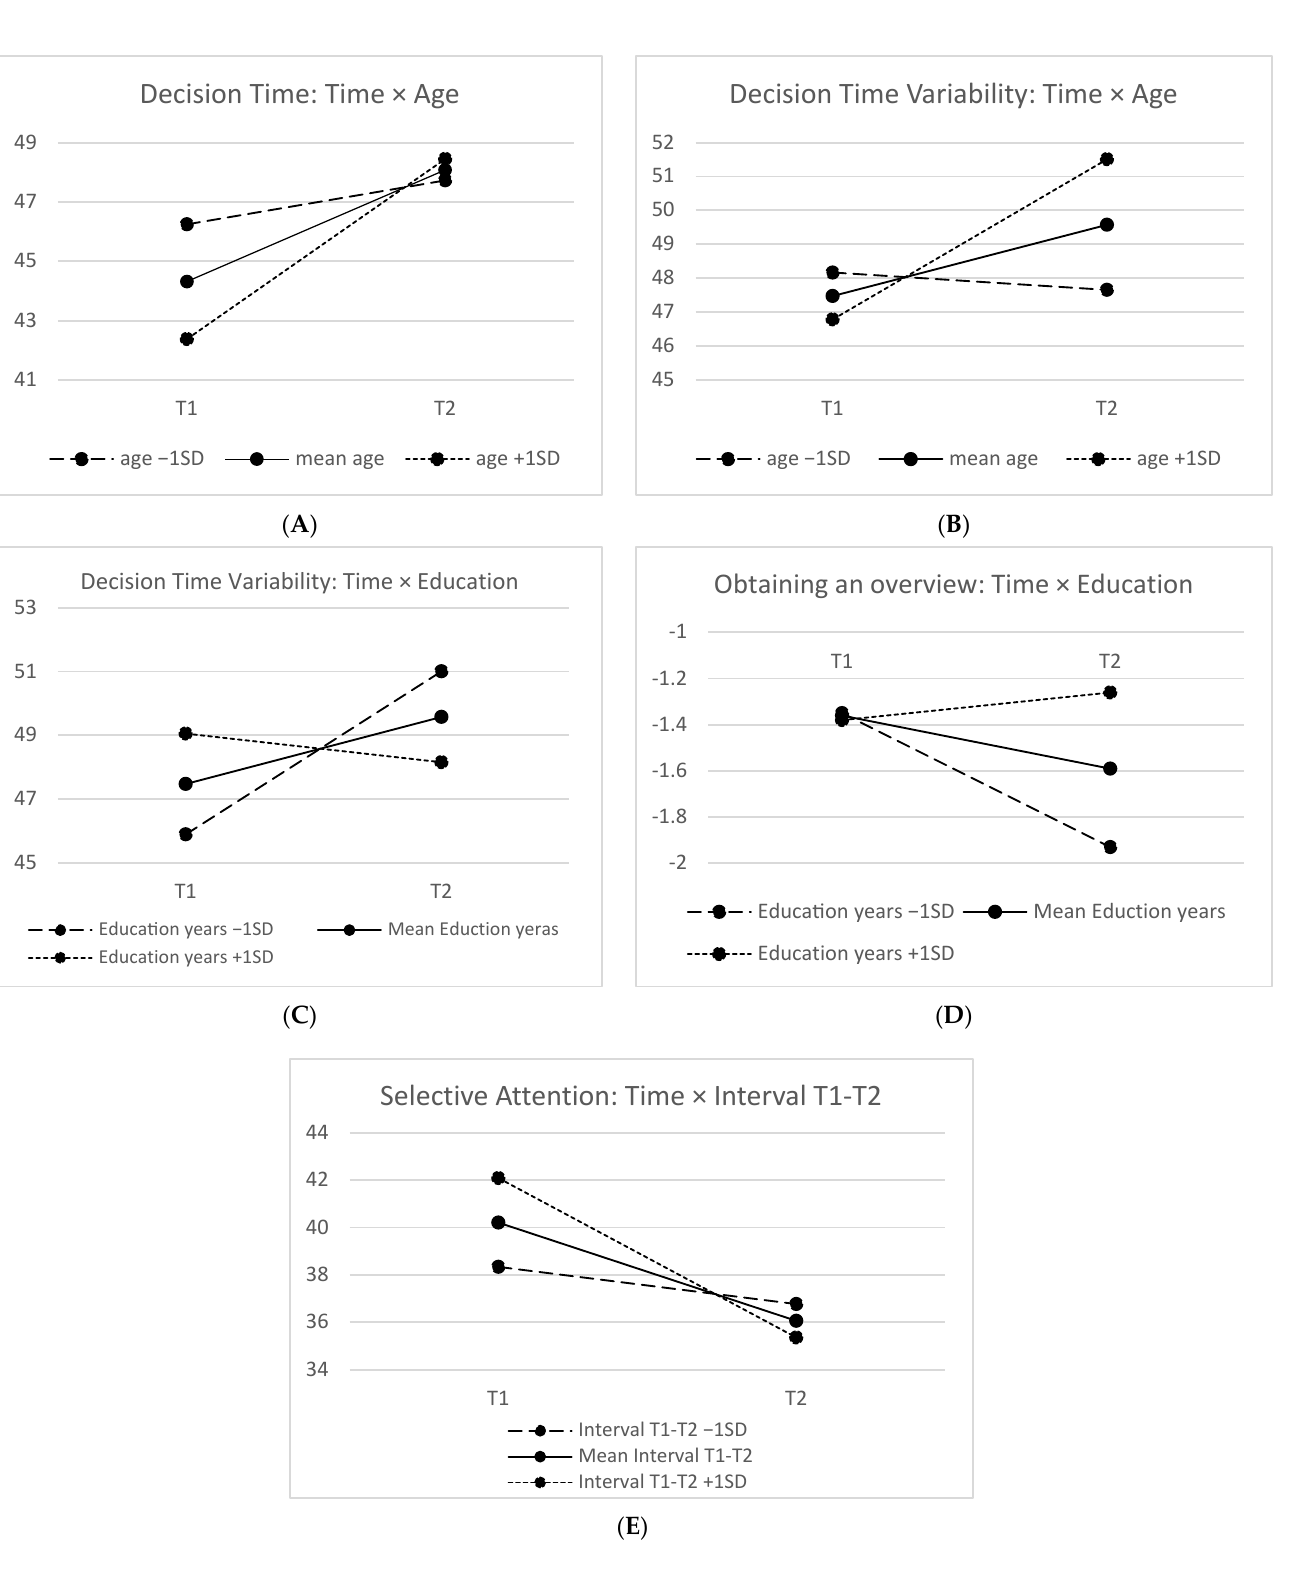
Figure 1. Significant interaction effects: ( A ) the effect of time on decision time by age; ( B ) the effect of time on decision time variability by age; ( C ) the effect of time on decision time variability by education; ( D ) the effect of time on perceptual speed by education; ( E ) the effect of time on selective attention by T1–T2 interval length.